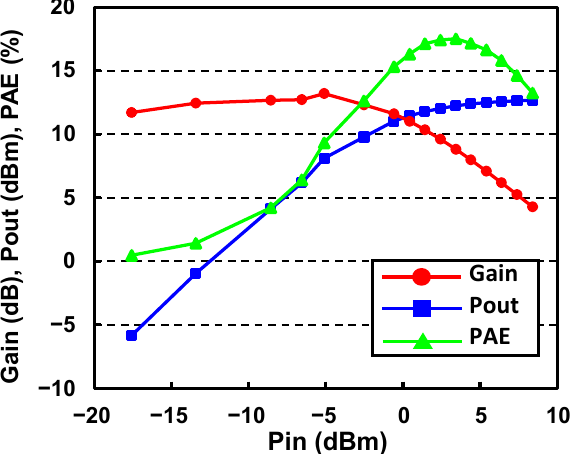
Figure 10. Measurement results of gain, output power, and PAE at 81 GHz.